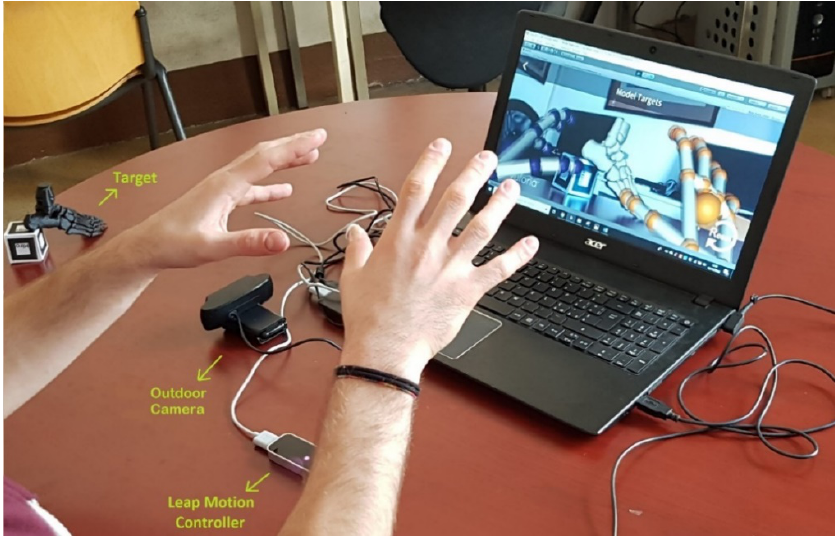
Figure 10. Leap motion controller .